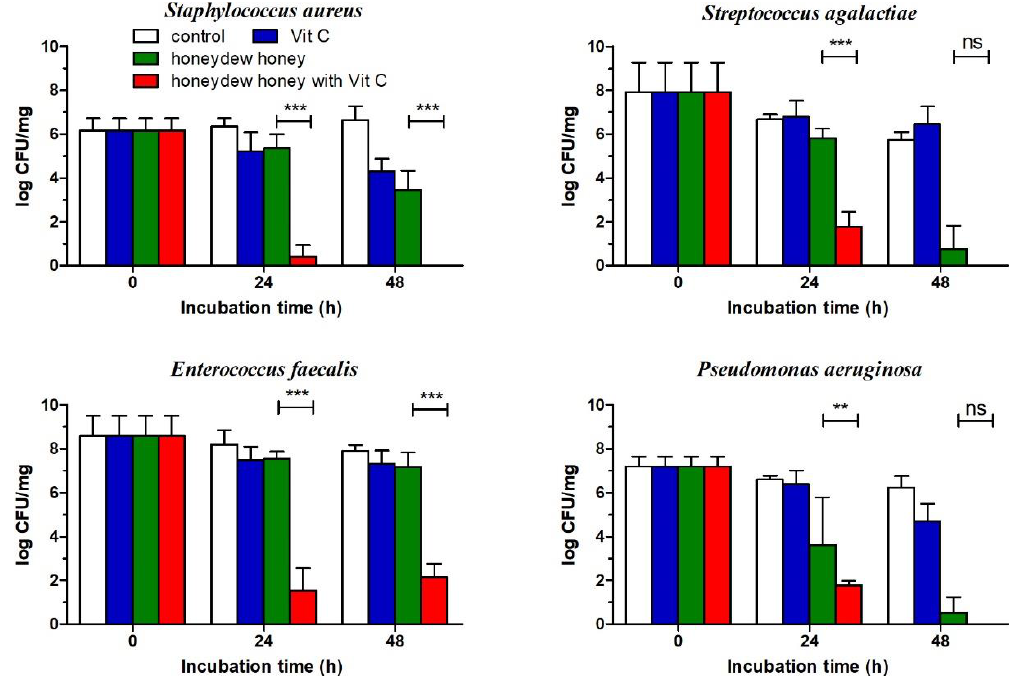
Figure 5. The antibiofilm e ff ects of Vit C (100 mg / mL), honeydew honey, and honeydew honey supplemented with Vit C at a concentration of 100 mg / g of honey against particular bacterial species forming a modified Lubbock chronic wound biofilm after 24 h and 48 h of treatment. The data are expressed as mean values with standard deviations. ** P < 0.01; *** P < 0.001; ns: non-significant.